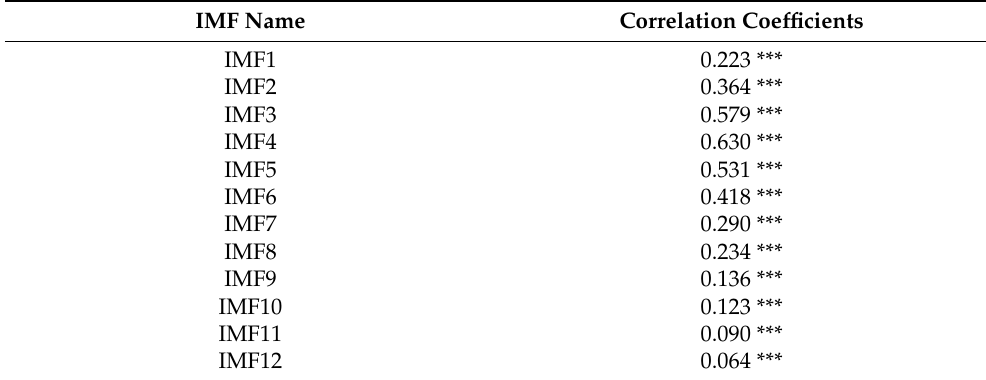
Table 1. Table of correlation